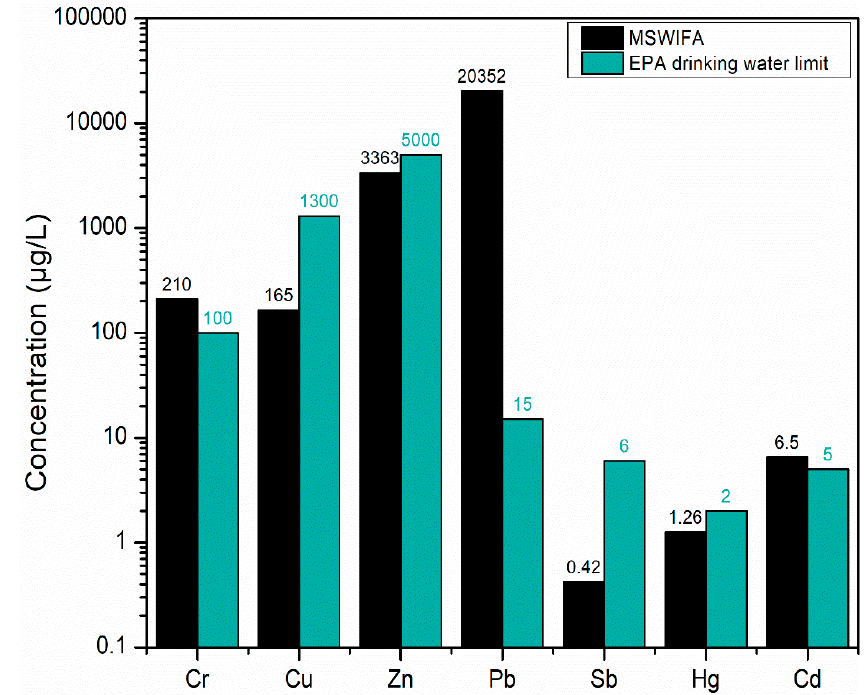
Figure 4. Concentrations of MSWIFA powder leachate and EPA drinking water limit. In the rest of this section, the encapsulation of each heavy metal is discussed.